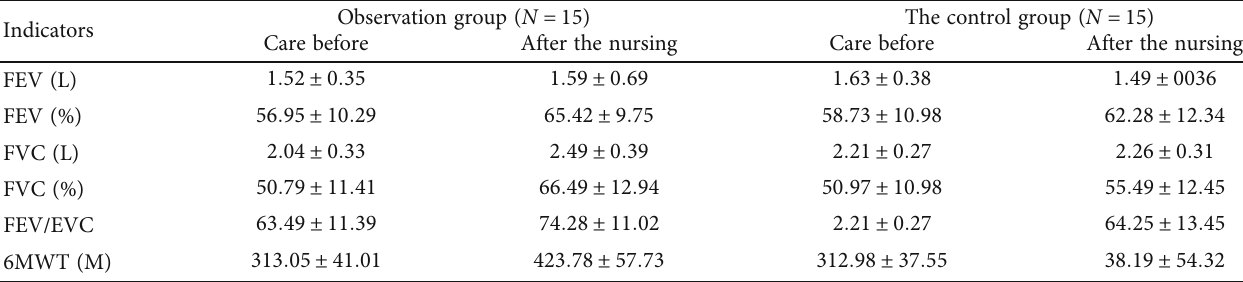
Table 1: Comparison of various indicators before and after nursing in the two groups.